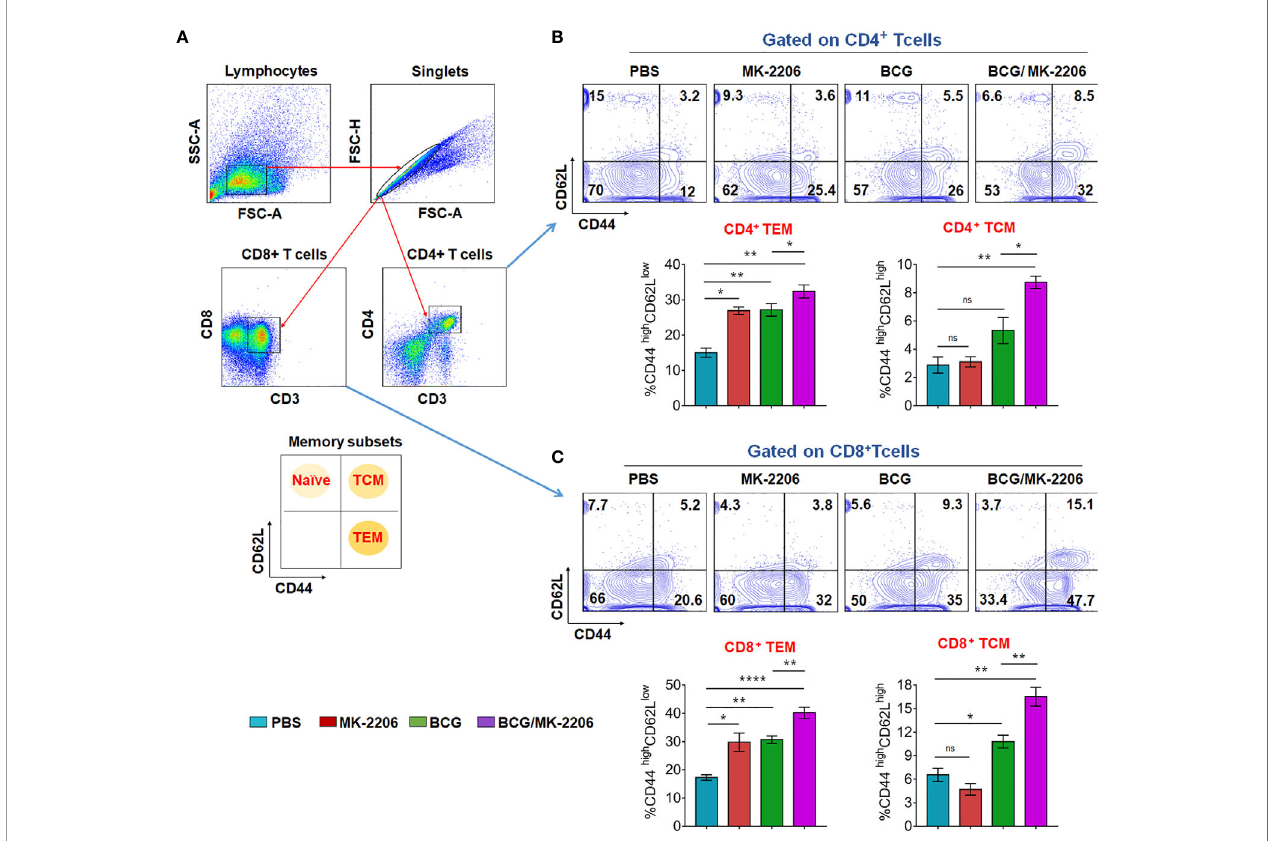
FIGURE 6 | BCG/MK-2206 prime boost regimen induces expansion of effector and central memory T cells. Sixty days post immunization, mice from each group were sacri fi ced and single cells suspension from spleens were prepared as described in Materials and Methods . Splenocytes were stimulated in vitro with PPD for analysis of antigen speci fi c memory T cells responses. Live cells were stained with anti-CD3, anti-CD4, anti-CD8, anti-CD44 and anti-CD62L, data was acquired by fl ow cytometry and subsequently analyzed by FlowJo software. (A) Gating strategy used to de fi ne CD4 + and CD8 + memory T cells. Debris were excluded based on FSC and SSC parameters and doublets were excluded in FSC-H versus FSC-A plots. After CD3 + gating, the gated populations of CD4 + and CD8 + T cells were further checked for the expression of memory markers of naïve (CD62L high CD44 low ), central memory (CD62L high CD44 high ) and effector memory (CD62L low CD44 high ) T cells. (B, C) Representative dot plots showing the percentage of TEM and TCM within CD4 + (B) and CD8 + (C) cells. The histograms represent total number of TEM and TCM within CD4 + (B) and CD8 + (C) T cells. Data shown in these panels is mean ± SEM obtained from a single experiment (n=5 mice/group). Statistical differences were obtained for the indicated groups. ns, non-signi fi cant; *p < 0.05; **p < 0.01; ****p < 0.0001; ns, non-signi fi